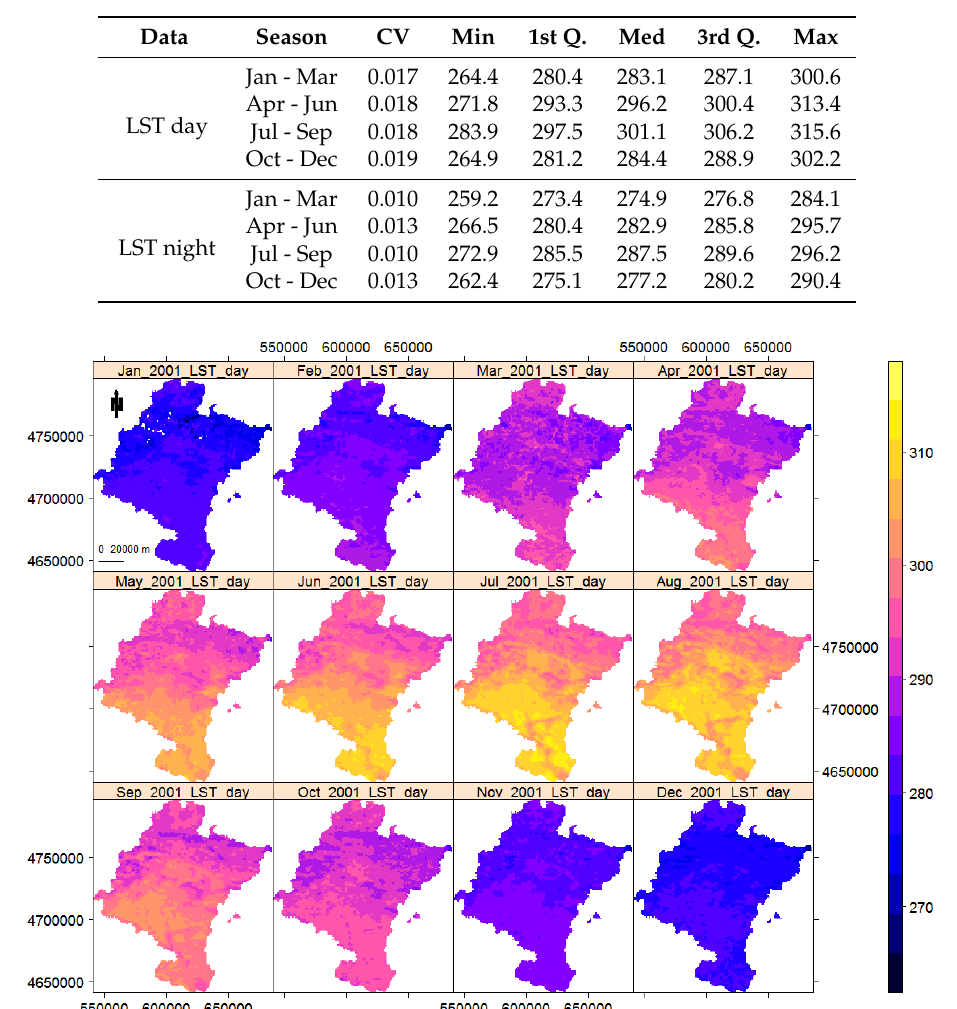
Table 4. Descriptive statistics for LST day and night of Navarre, Spain, during 2001–2018. Coefficient of variation (CV), minimum (Min), first quartile (1st Q.), median (Med), third quartile (3rd Q.), and maximum (Max). CV is unit-free and the rest are given in Kelvin degrees.